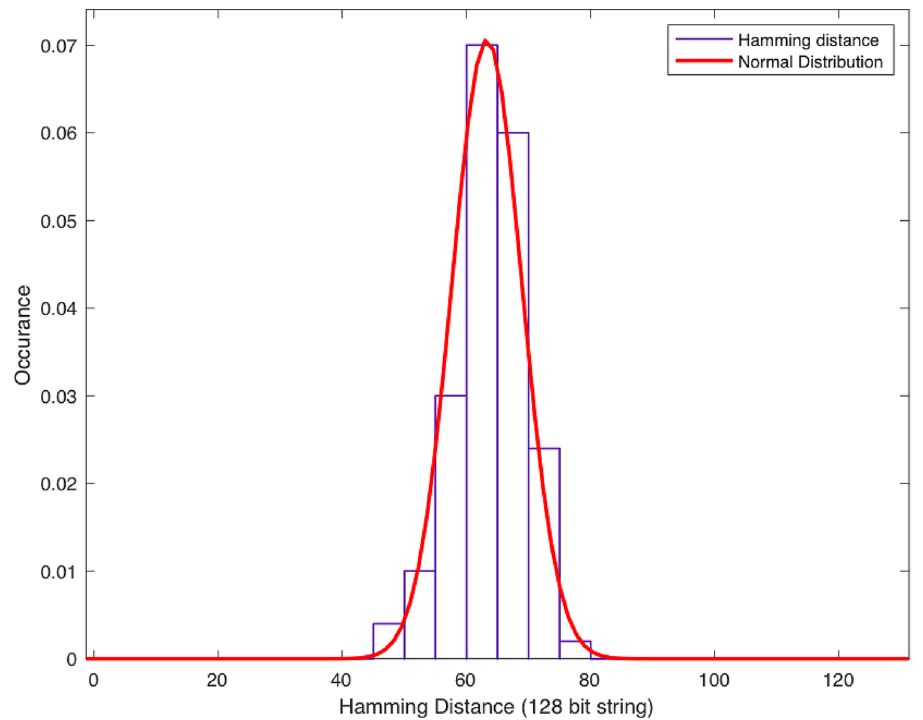
Figure 9. Hamming distance distribution for evaluating diffuseness: mean of HD is 63.43 which is 49.6% which is almost 50% the ideal value).